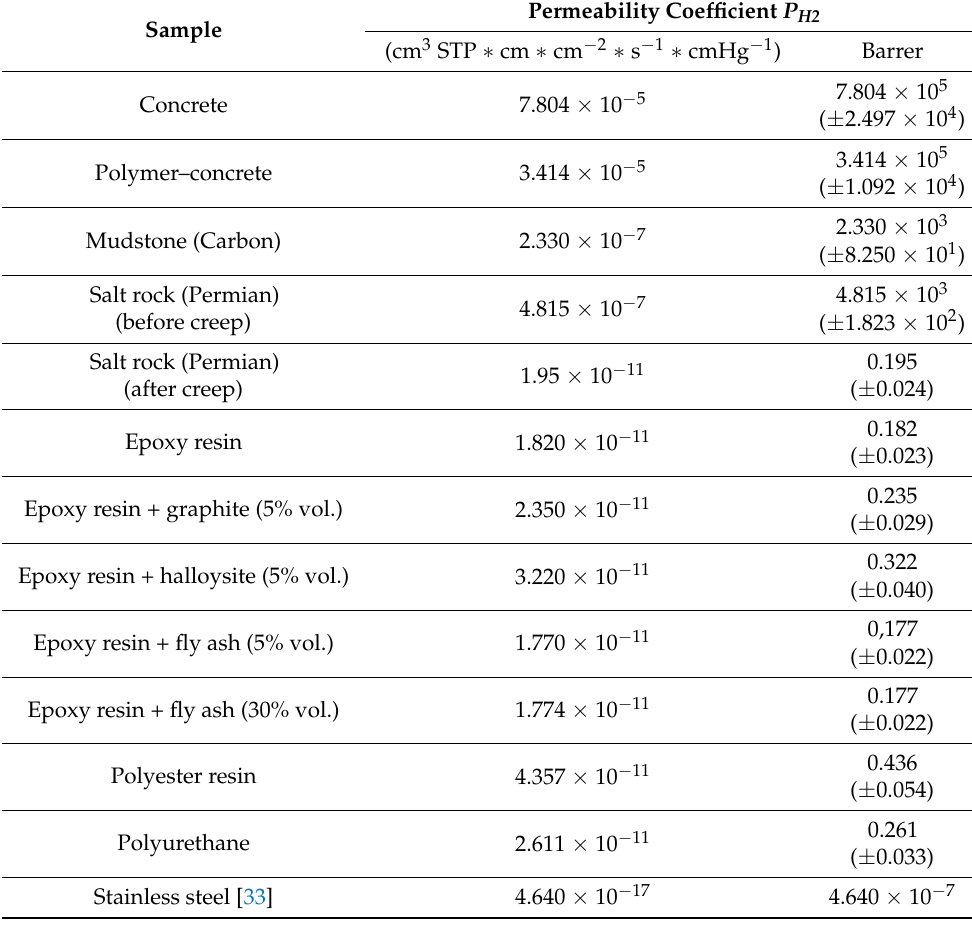
Table 4. Hydrogen permeability obtained in experimental methods [26,32].